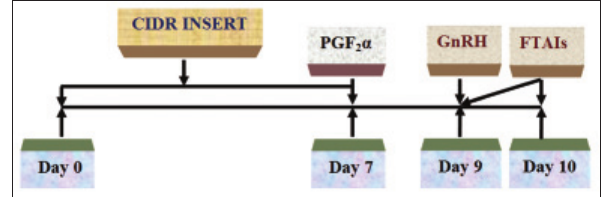
Figure-1: CIDR protocol of estrus synchronization.